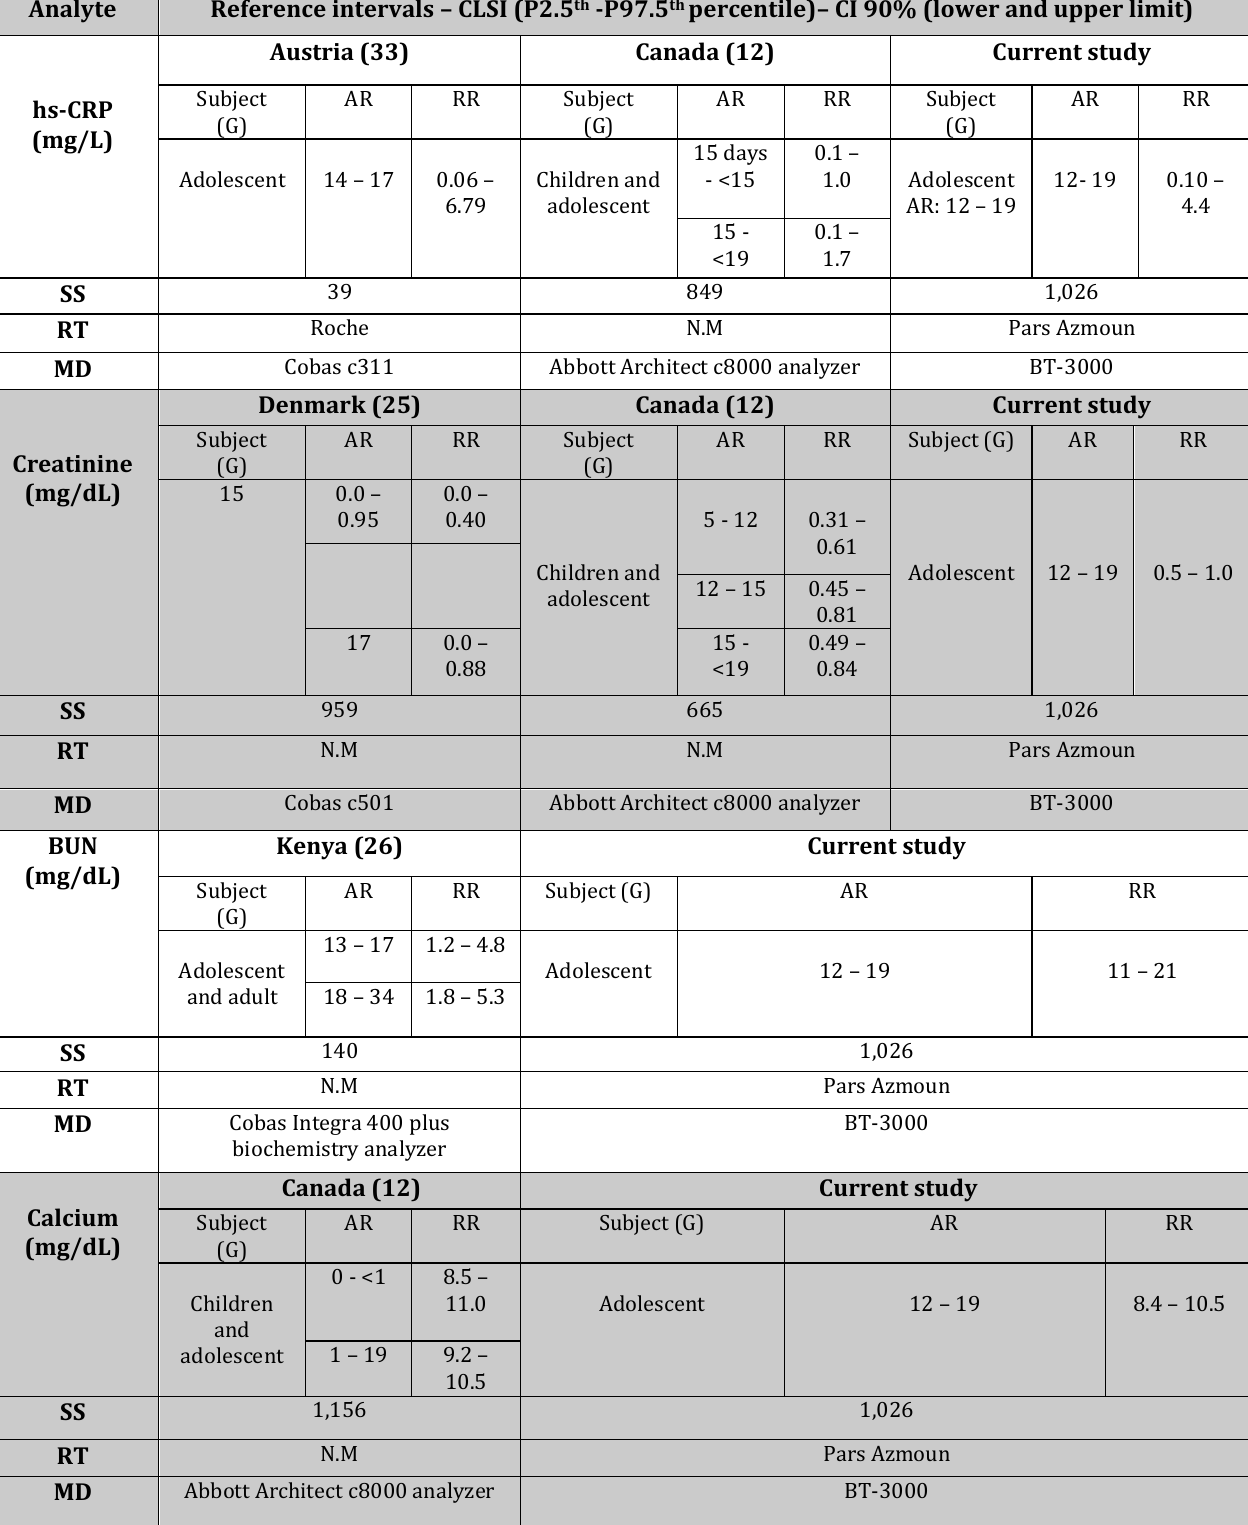
Continue Table 2 . Comparison of reference intervals of the current study population with reference intervals of other